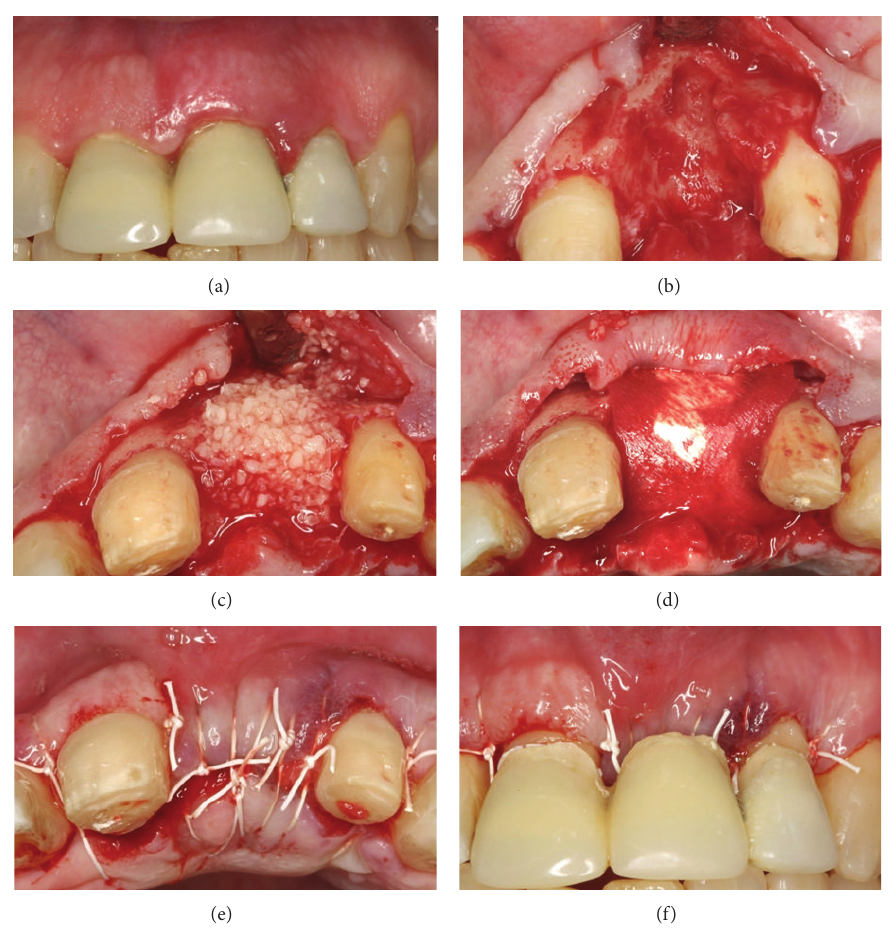
Figure 2: Clinical views of Case 2. (a) Pretreatment and after (b) extraction, (c) bone graft placement, (d) adaptation of the collagen matrix, (e) suturing, and (f) insertion of the temporary